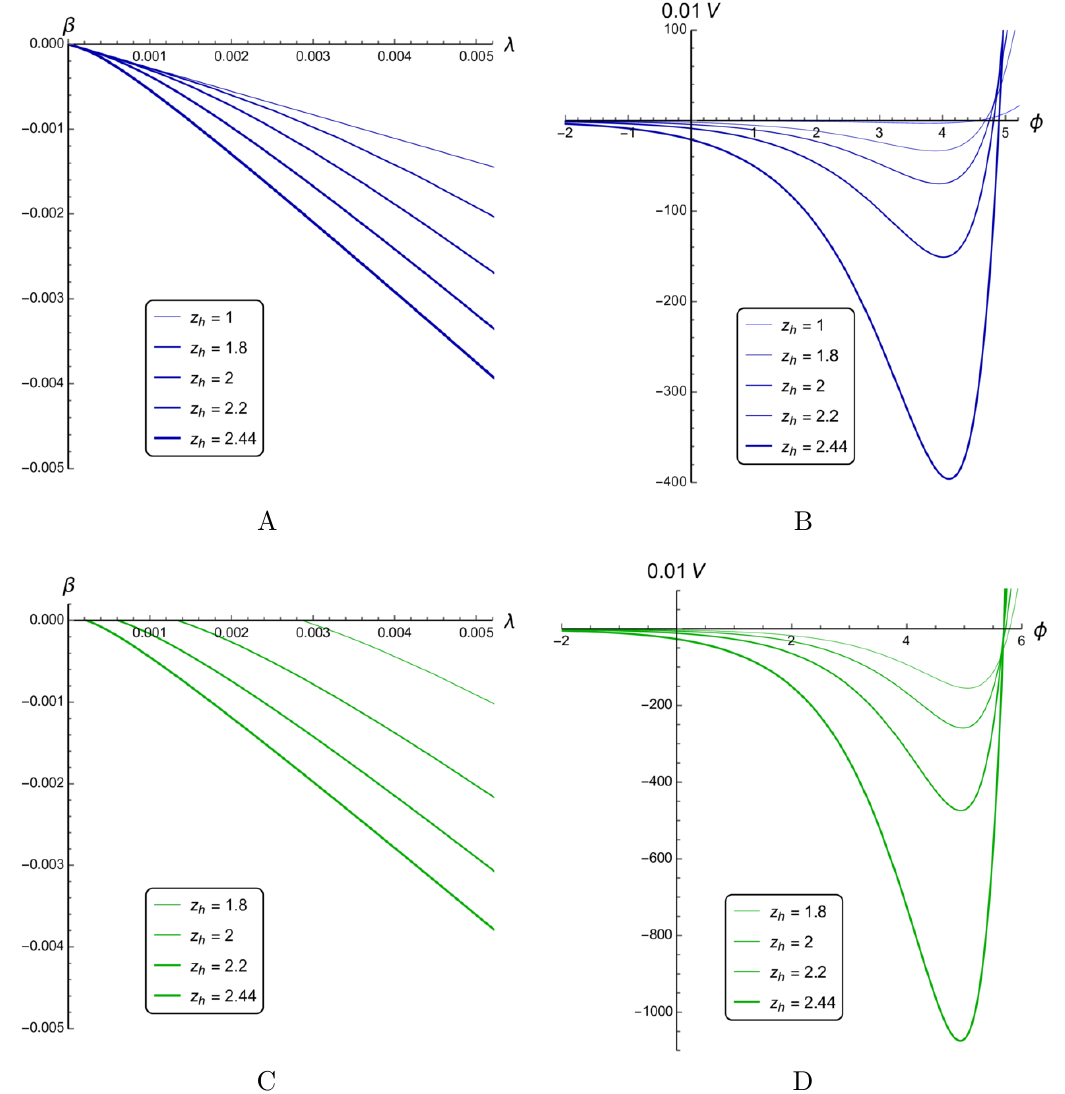
Figure 13 . The function (cid:12) ( (cid:21) ) in anisotropic, (cid:23) = 4 : 5, (A) and isotropic, (cid:23) = 1, (C) cases near small (cid:21) ; scalar potentials V ( (cid:30) ) for (cid:22) = 0 in anisotropic, (cid:23) = 4 : 5, (B) and isotropic, (cid:23) = 1, (D) cases.